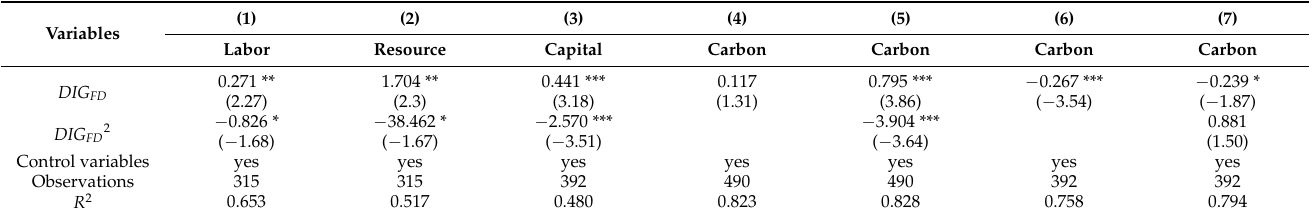
Table 9. Regression results for developing countries—heterogeneity